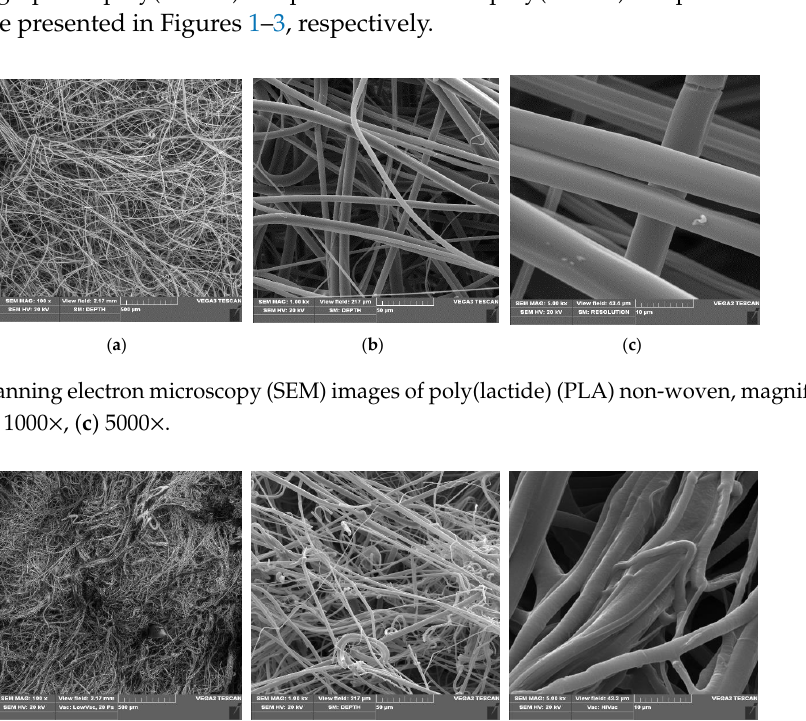
Figure 2. SEM images of PLA–Cu 0 (10), magnification: ( a ) 100×, ( b ) 1000×, ( c ) 5000×.